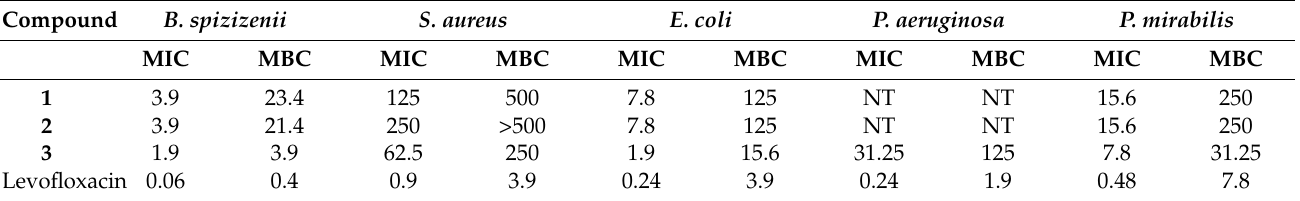
Table 2. The minimum inhibitory concentration (MIC) and minimum bactericidal concentration (MBC) results for the synthesized compounds compared to levofloxacin against five different bacteria. Concentrations were measured in µ M.